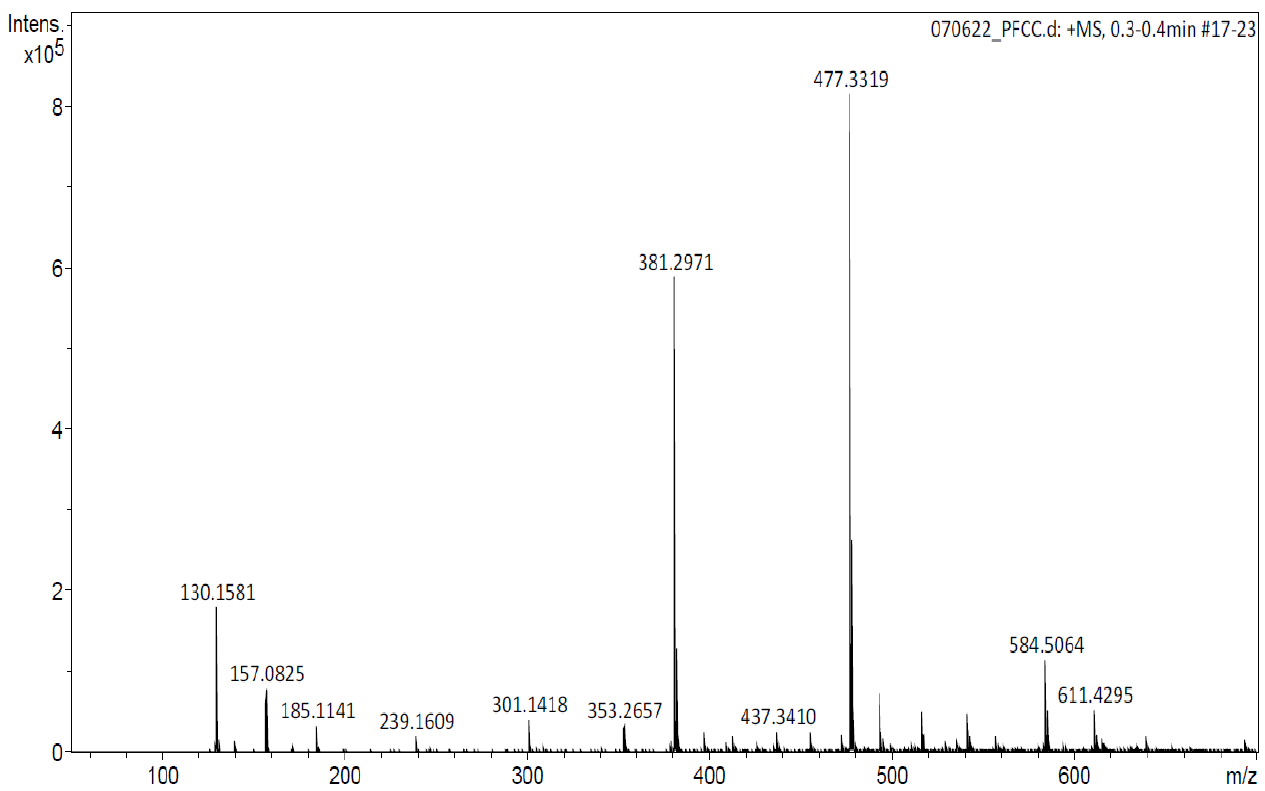
Figure 2. Electrospray spectrum (in the positive mode) for the white solid (fractions 227–256 of F1).